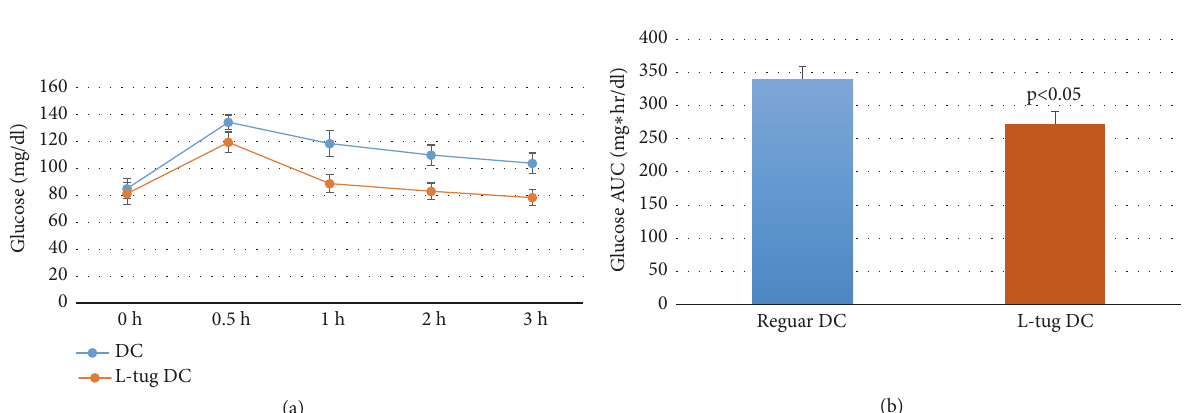
Figure 1: Changes in serum glucose (a) and area under the curve (AUC, (b)) for serum glucose concentration after ingestion of regular and L-tug dark chocolate (DC).